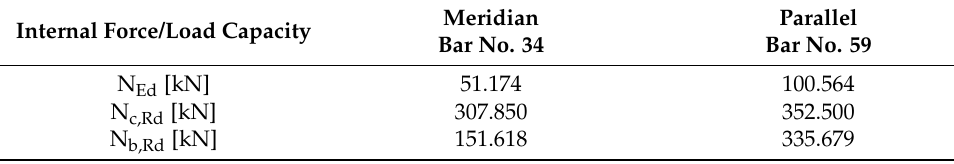
Table 4. Internal forces and cross-section capacities.